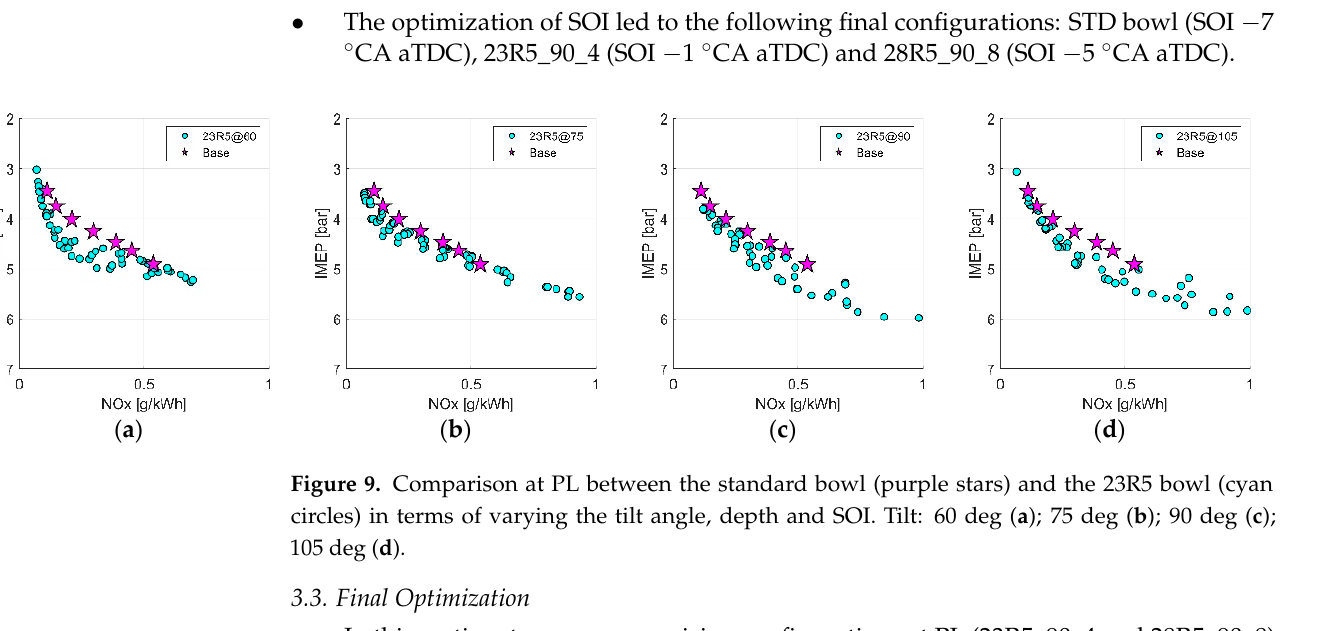
Figure 8. Comparison at PL between the standard bowl and 28R5_90_8 bowl in terms of the IMEP and specific NO x .